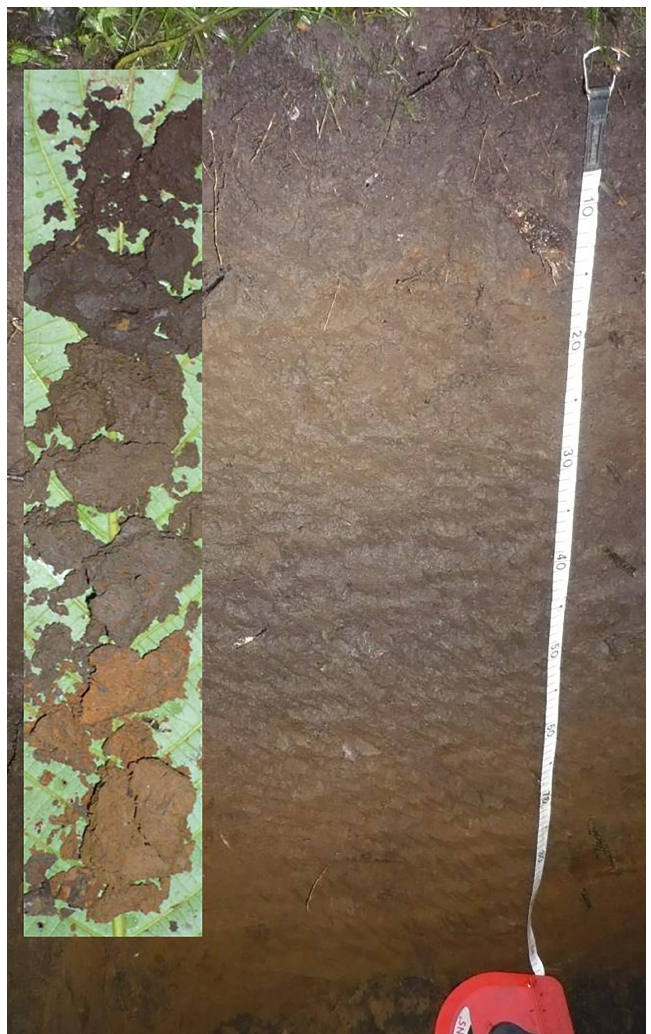
Figure A1. Profile of the studied